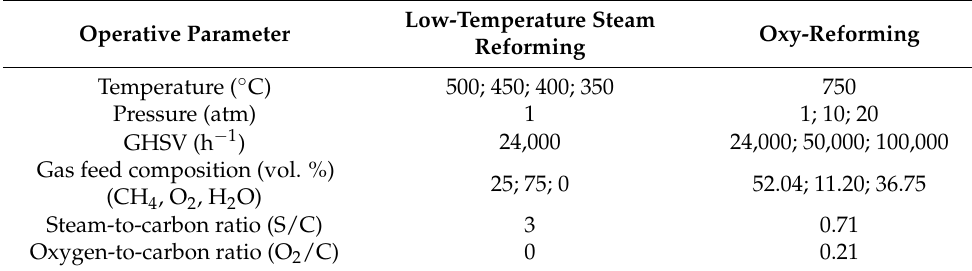
Table 1. Operative conditions employed in this work. Low-Temperature Operative Parameter